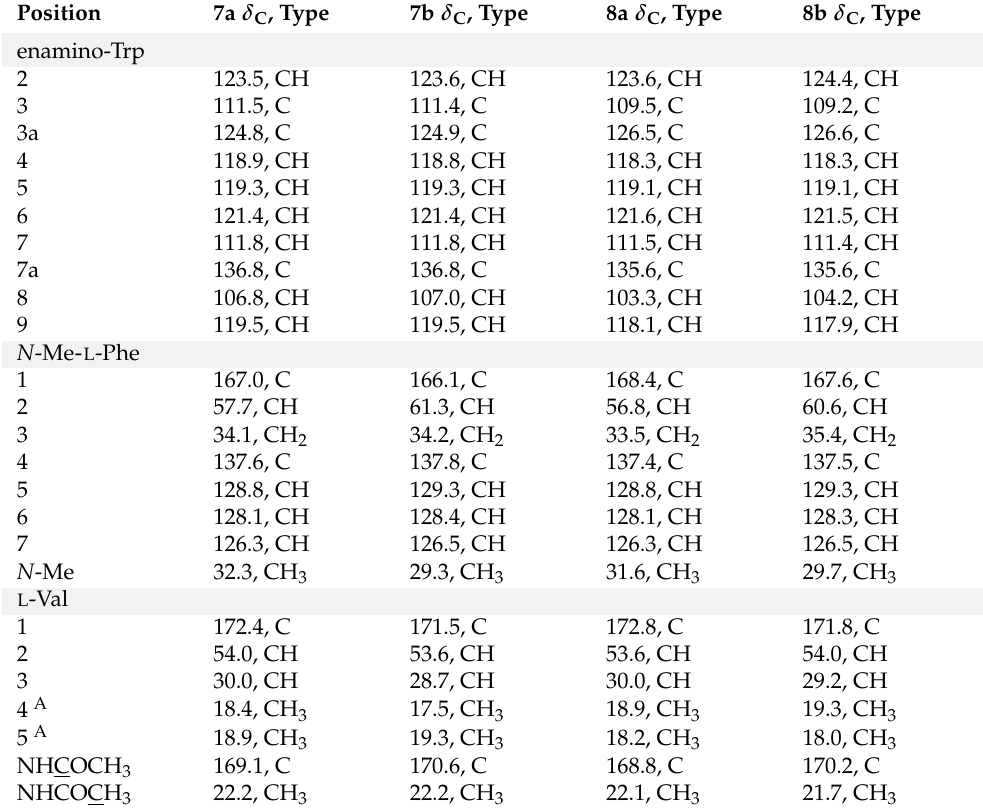
Table 2. 13 C NMR (DMSO- d 6 ) Data for aspergillamides E–F ( 7–8